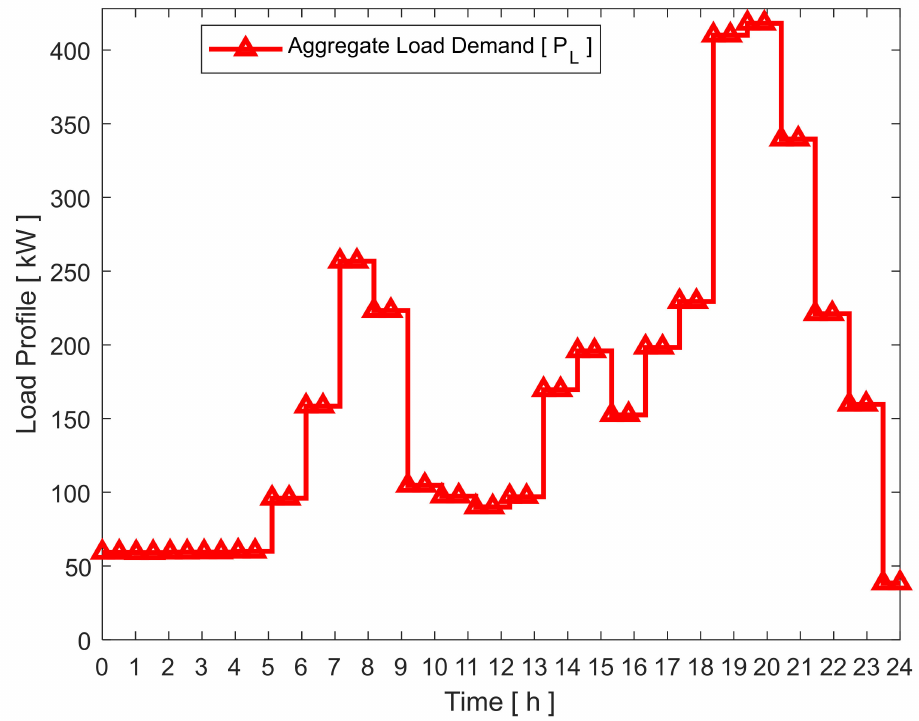
Figure 9. An aggregate daily energy demand profile of a typical remote